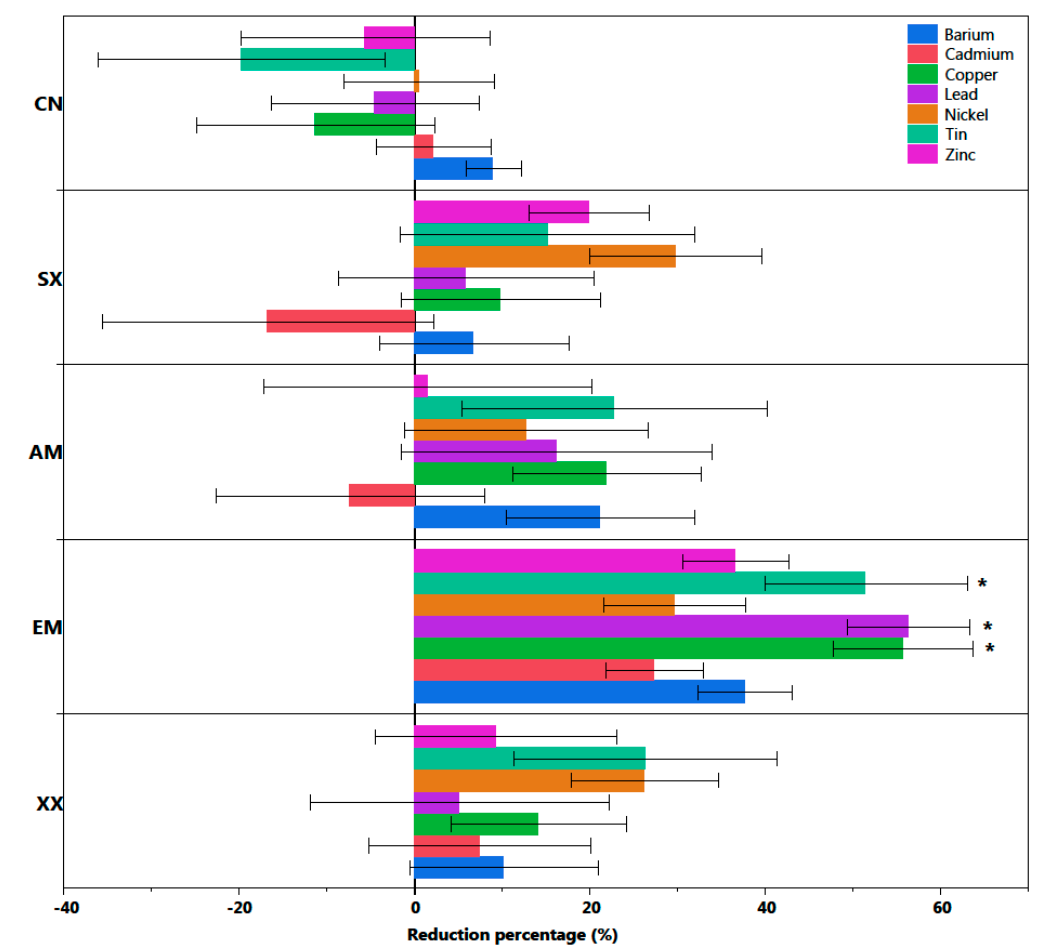
Figure 2. Average change in soil TE between 2016 and 2019 in five treatment plots of Salix miyabeana SX67 ( n = 5 for each treatment), shows that only the EM treatment had significant decreases (Sn, Pb, and Cu). Negative values indicate an increase in concentration. Error bars represent standard error. SX = Willow non-inoculated; AM = Willow + AMF inoculation; EM = Willow + ECM inoculation; XX = Willow + AMF + ECM inoculation; CN = Non-planted control. Asterisks (*) indicate that the percent reduction of TE concentration is significantly di ff erent from other treatments Table 3. ANOVA analysis of the aerial dry biomass of S. miyabeana SX67 and the TE percentage decrease/increase in the soil for each treatment after two growing seasons at the Longueuil, Québec industrial landfill site.